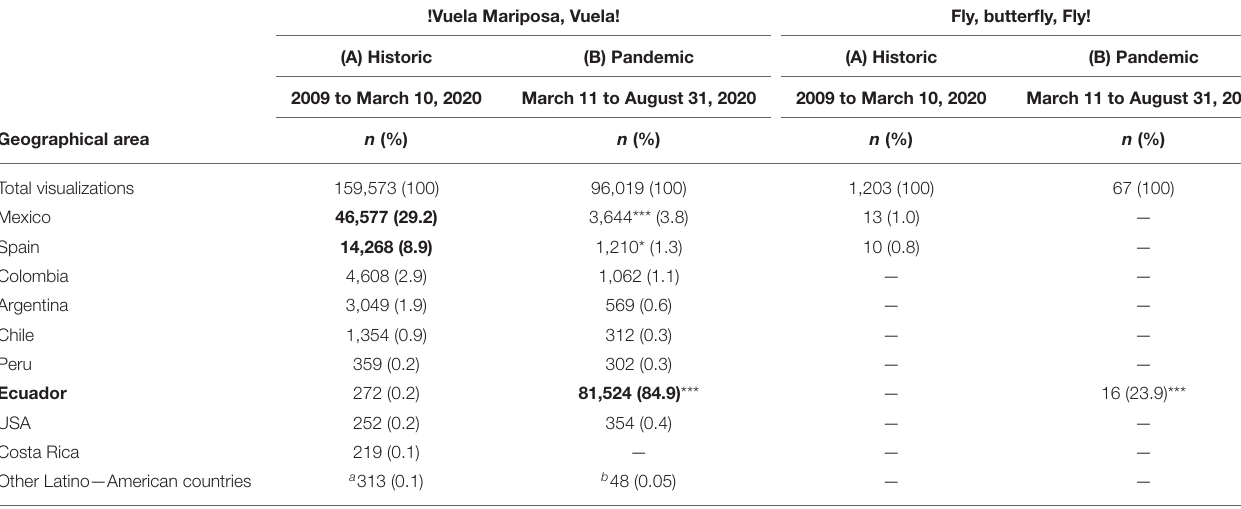
TABLE 3 | Comparative analysis on the use of the children’s story on the cycle of life, death, and grief—geographic